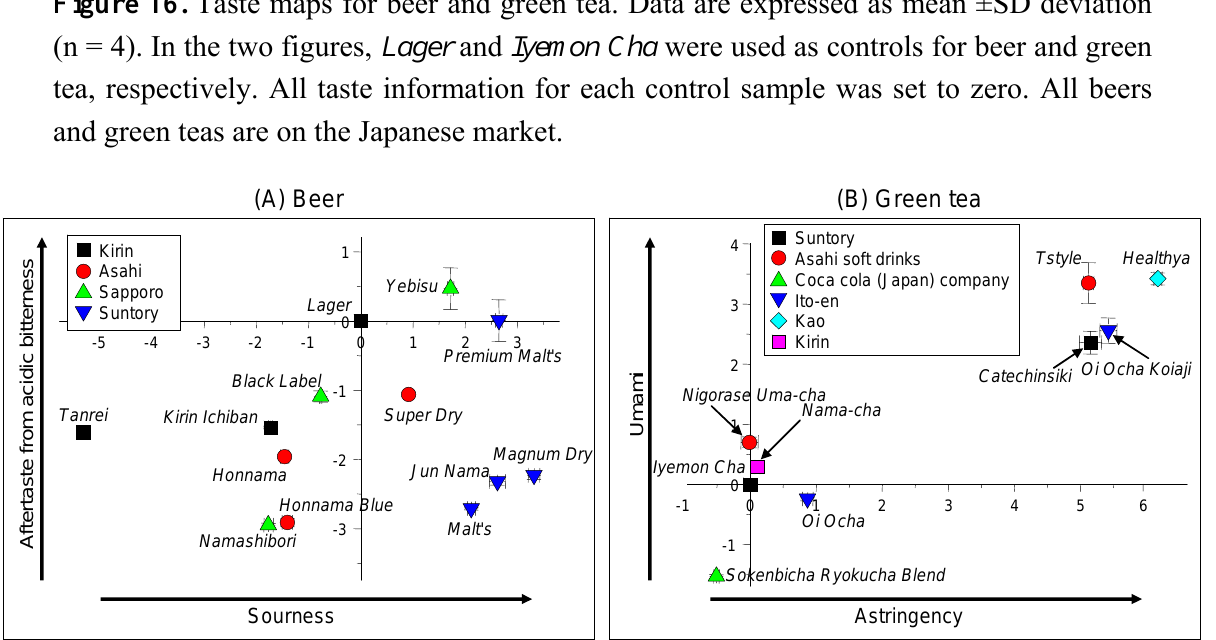
Table 3. For example, when the “saltiness” taste information is 12.6, the saltiness intensity is considered to be equivalent to 270 mM of potassium chloride. In other words, when a tasteless sample